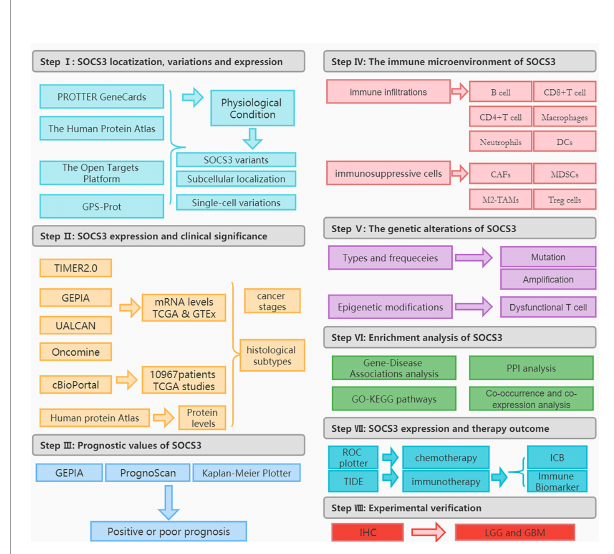
FIGURE 1 | The fl owchart of this